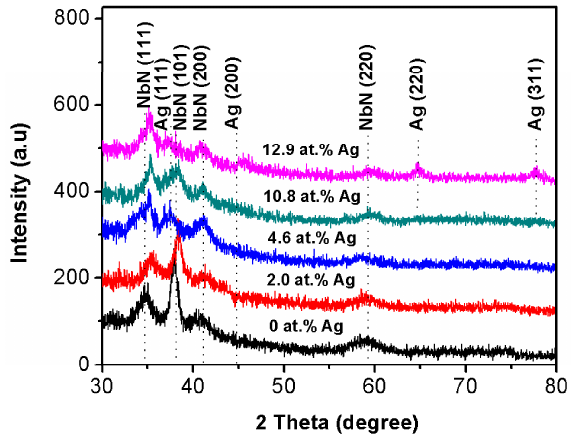
Figure 2. X-ray diffraction (XRD) patterns of NbCN-Ag composite films with different Ag content.